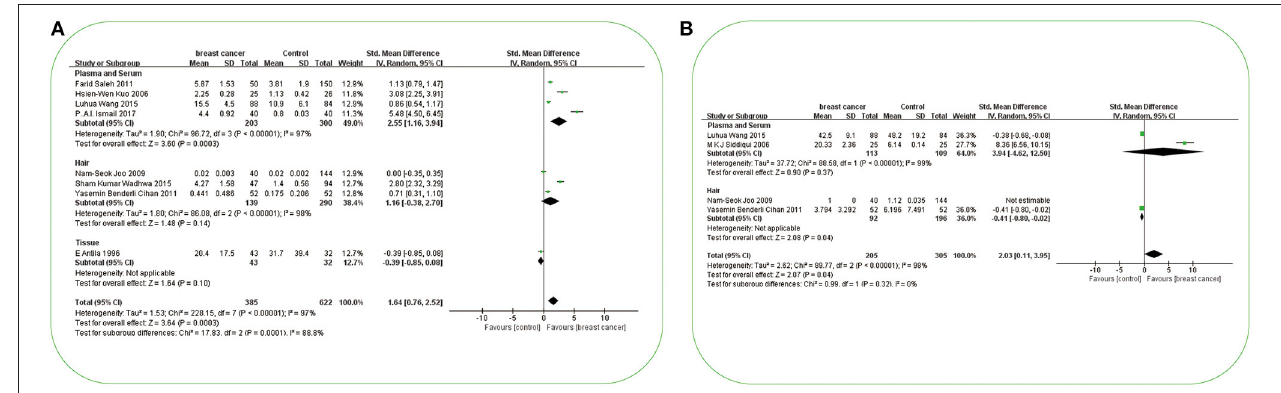
FIGURE 5 | Forest plot of studies of potential toxic trace elements in subjects with breast cancer vs. non-breast cancer controls. (A) Forest plot of studies of Cd levels in subjects with breast cancer vs. non-breast cancer controls. (B) Forest plot of studies of Pb levels in subjects with breast cancer vs. non-breast cancer controls. The